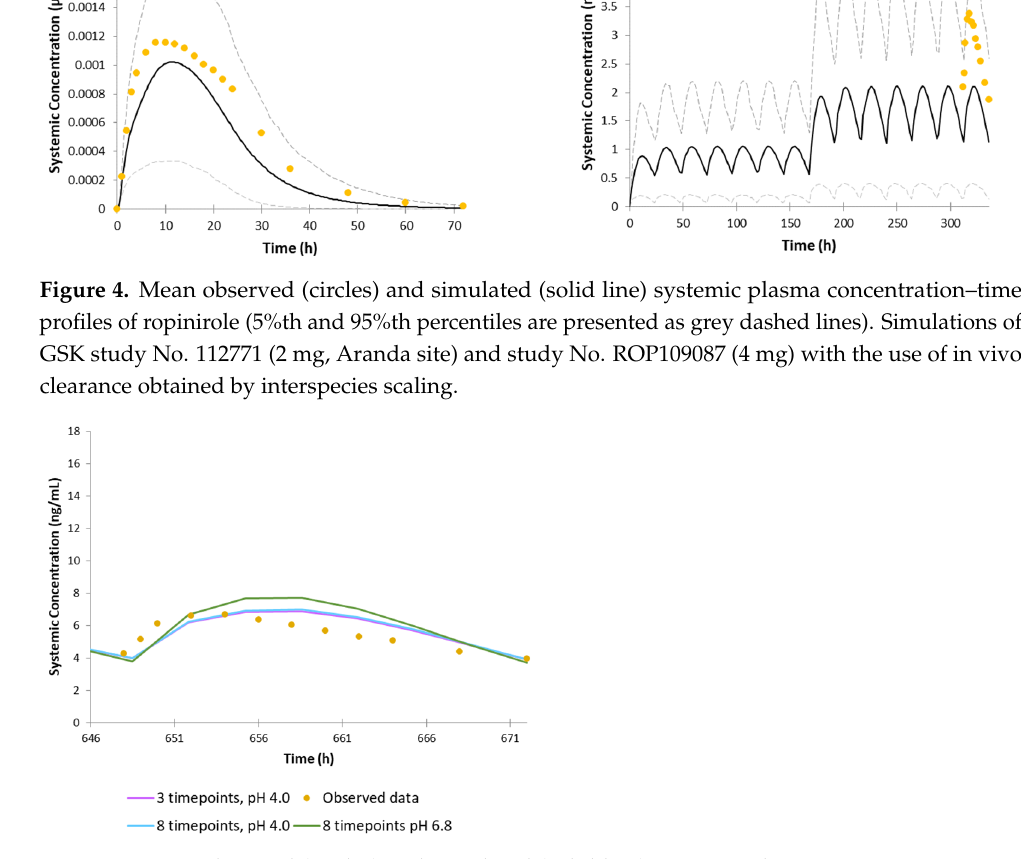
Figure 5. Mean observed (circles) and simulated (solid line) systemic plasma concentration–time profiles of ropinirole (5%th and 95%th percentiles are presented as grey dashed lines). Comparison of the simulations of GSK study No. ROP109087 (8 mg) with the use of three-timepoint dissolution profile, eight-timepoint dissolution profile obtained at pH 4.0, and eight-timepoint dissolution profile obtained at pH 6.8.